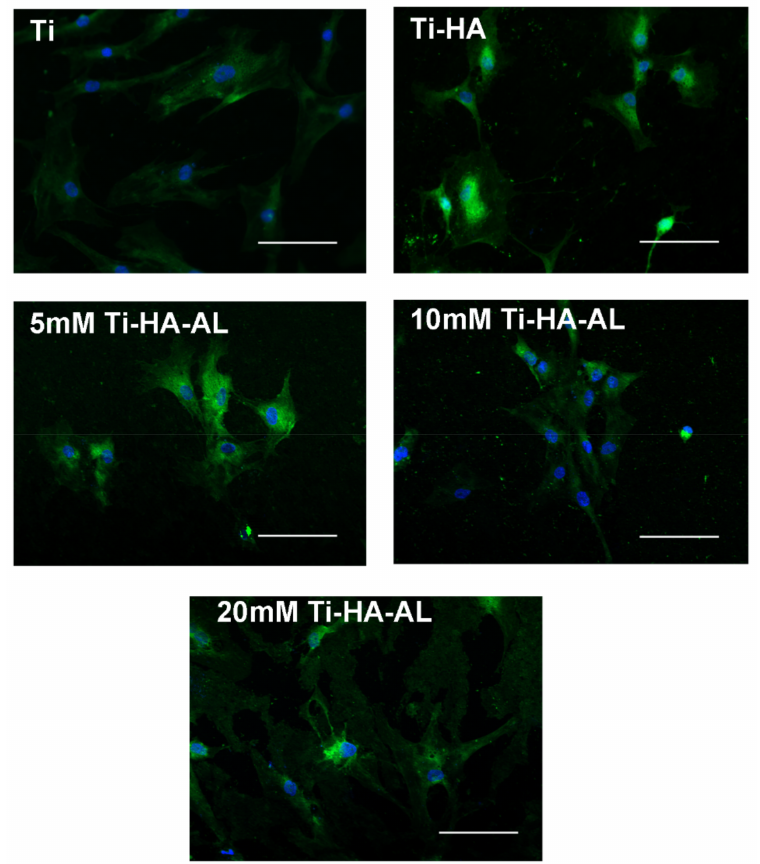
Figure 9. Immunofluorescence images of MSCs adhesion on HA-AL biomaterials: actin (green) was labeled with Alexa Fluor 488 conjugated phalloidin; the nuclei are labeled with DAPI (blue) for cell identification. Scale bar = 100 µ